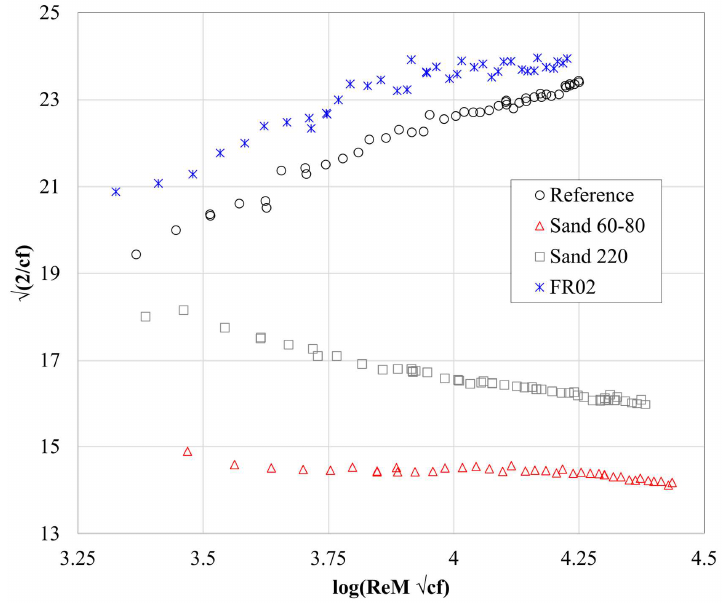
Figure 12. Exaggerated difference between the roughness functions of the smoothest and roughest coated